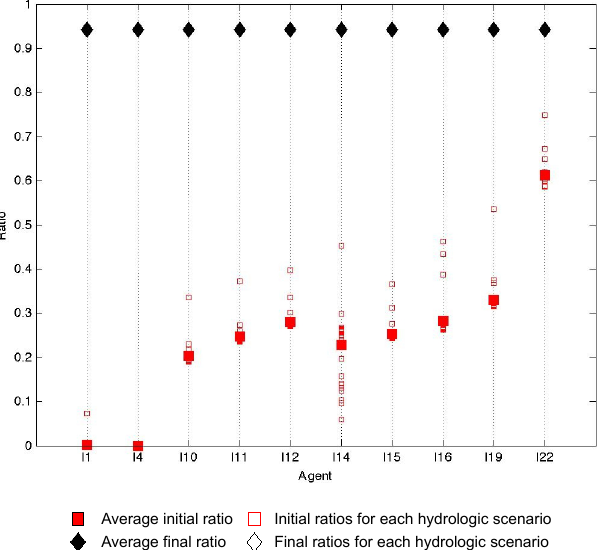
Figure 12. Initial and final ratios for irrigation agents.